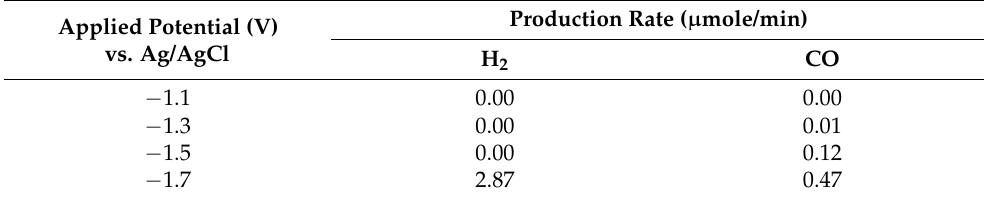
Figure 8. Current density of 0.05Bi/Sn during CO 2 RR at various applied potentials ( a ). Raman spectra of 0.05Bi/Sn electrode after CO 2 RR test at − 1.1 V (red), − 1.3 V (green), − 1.5 V (blue), and − 1.7 V (black) vs. Ag/AgCl ( b ). Table 2. Gaseous products distribution detected by GC-TCD at various applied potentials.